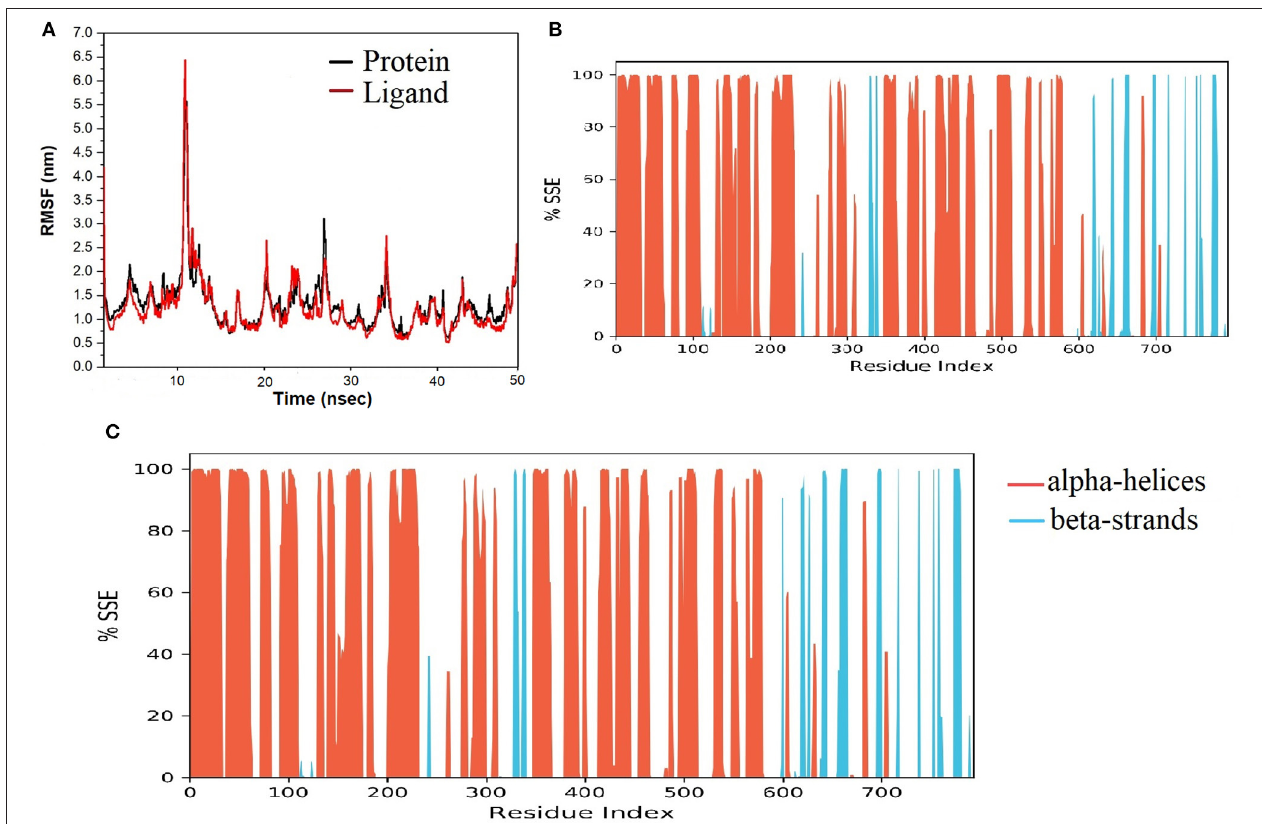
FIGURE 6 | Results of MD of NZO-SARS-CoV-2 S-protein-ACE-2 complex. (A) RMSF of the NZO-SARS-CoV-2 S-protein-ACE-2 complex. RMSF of protein and ligand were < 2 Å for most of the simulation time. (B) Secondary structure elements (SSE) of the apo form of SARS-CoV-2 S-protein-ACE-2. (C) SSE of the NZO-SARS-CoV-2 S-protein-ACE-2 complex. No significant change in the percentage of SSE between the apo and bound proteins indicates conformational